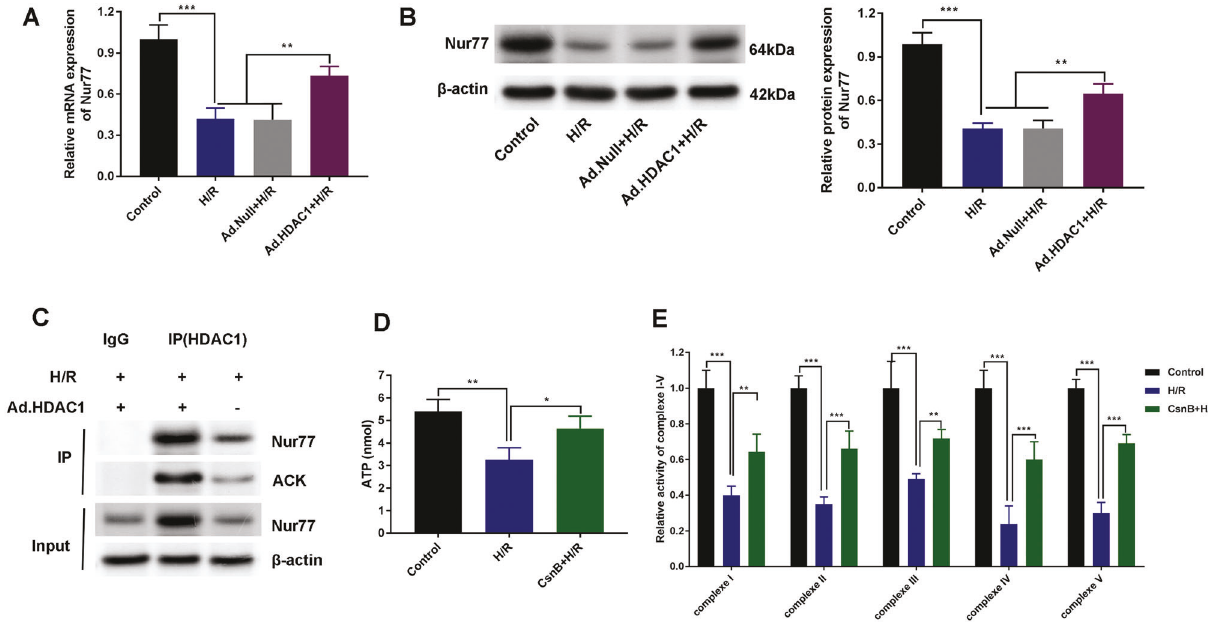
Fig. 4 HDAC1 participates in mitochondrial metabolic reprogramming through the regulation of Nur77 deacetylation. A qRT-PCR and B western blot analysis of Nur77 expression in H/R Raw264.7 cells transfected with Ad.HDAC1. C Acetylation (AC-K) of Nur77 regulated by HDAC1 evaluated through Co-IP assays. D ATP production in H/R following CsnB transfection. E Complex I, II, III, IV, and V activity in RAW264.3 cells ( n = 3). Data represent the mean ± SD. * P < 0.05, ** P < 0.01, *** P <